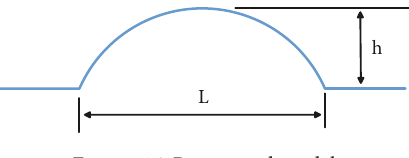
Figure 16: Bump road